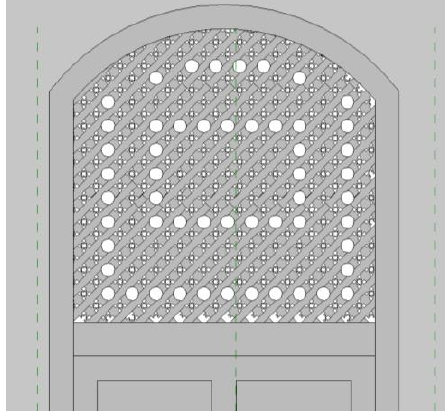
Figure 6: Door with Manjur pattern as Rivet family.